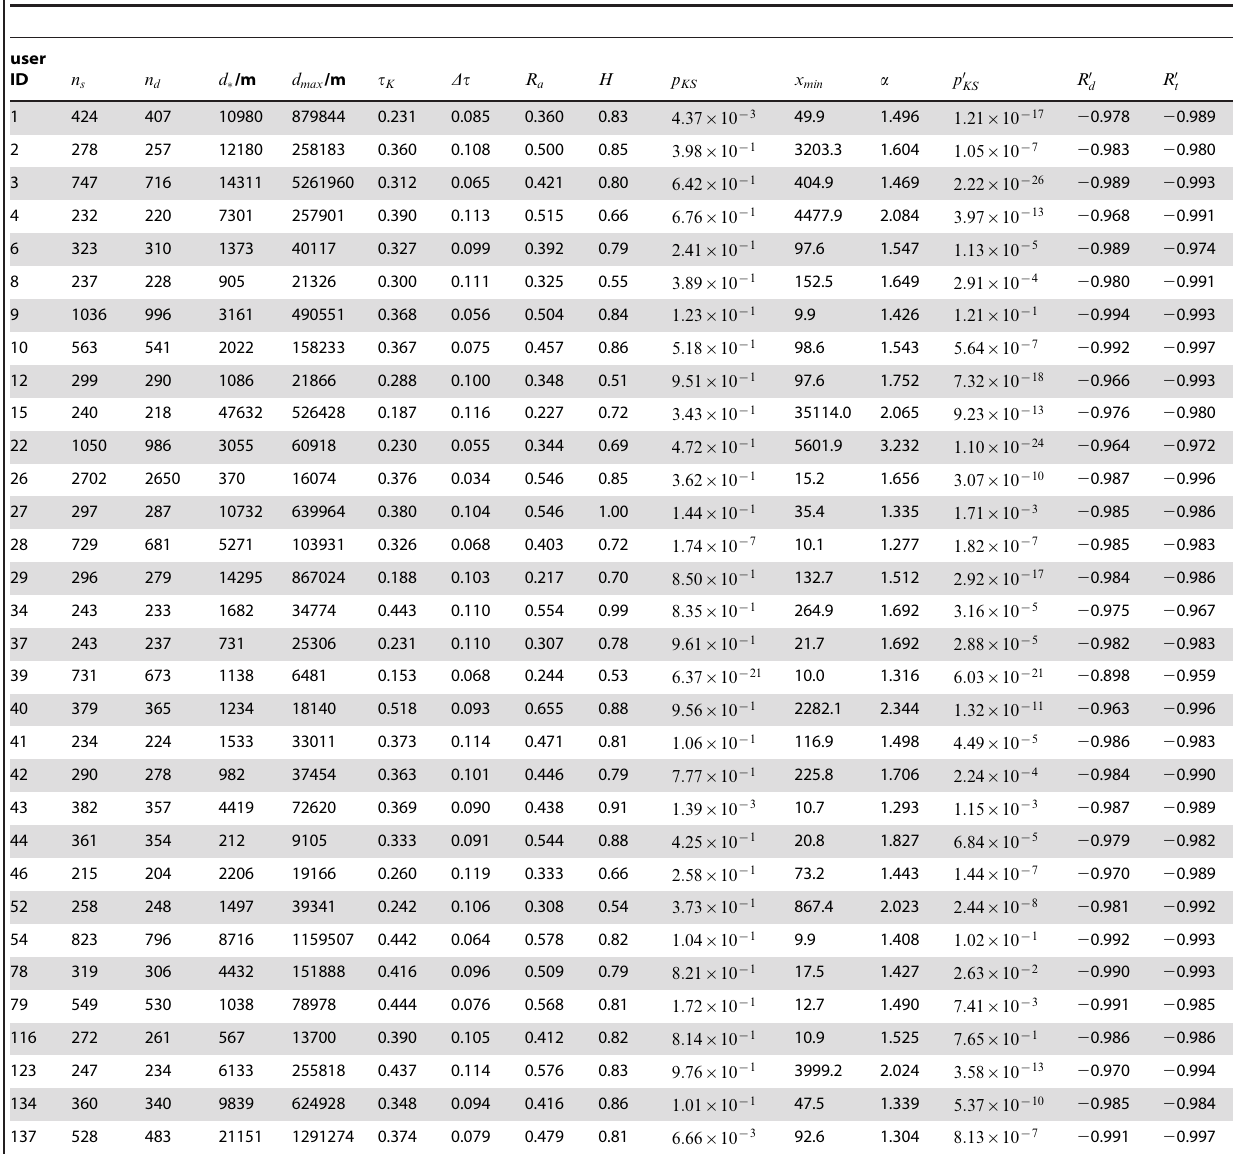
Table 1. Information and fitting parameters of the 32 individuals, where n s and n d are the number of effective staying positions and displacements of each user, d (cid:2) and d max are the average displacement and the maximum displacement of the user, and a is the fitting exponent of P ( d ) using the estimated lower bound x min